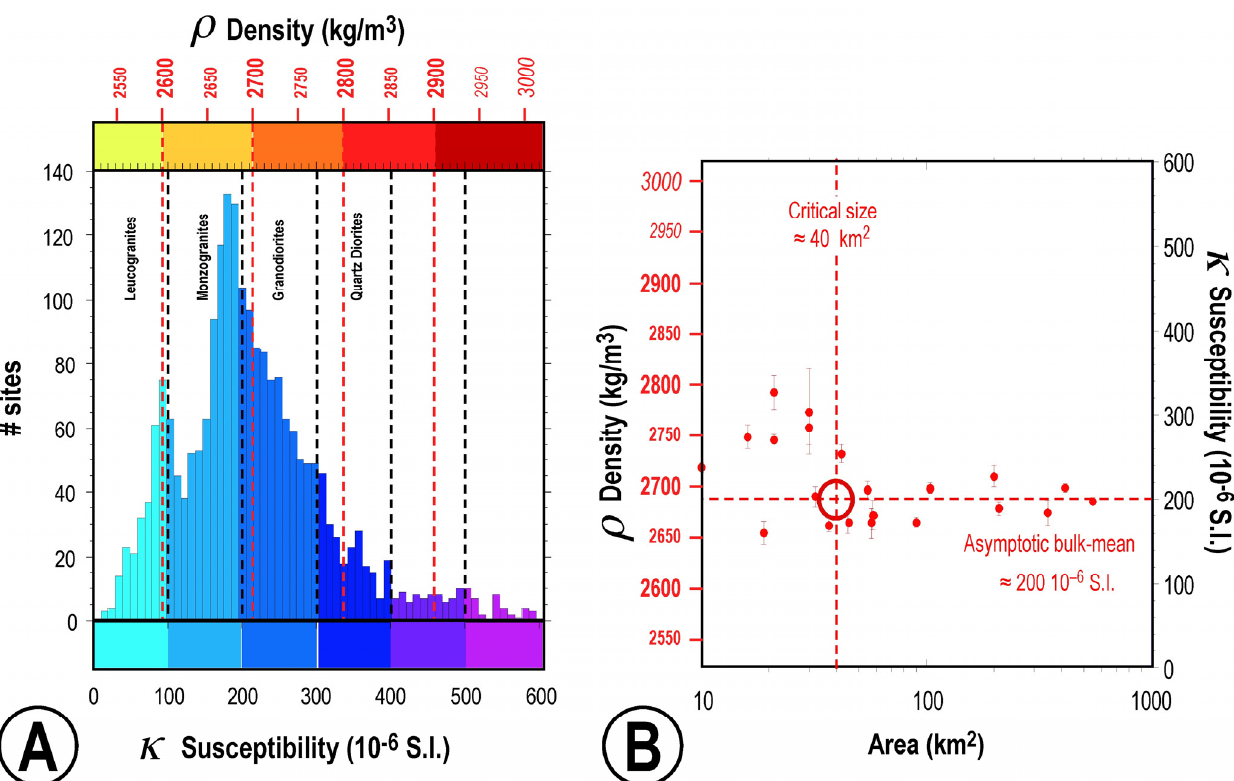
Figure 13. ( A ) Histogram of the magnetic susceptibility (site means) and density data in the Pyrenees (derived from the AMS database). ( B ) mean magnetic susceptibility vs. granite body size (km 2 ).